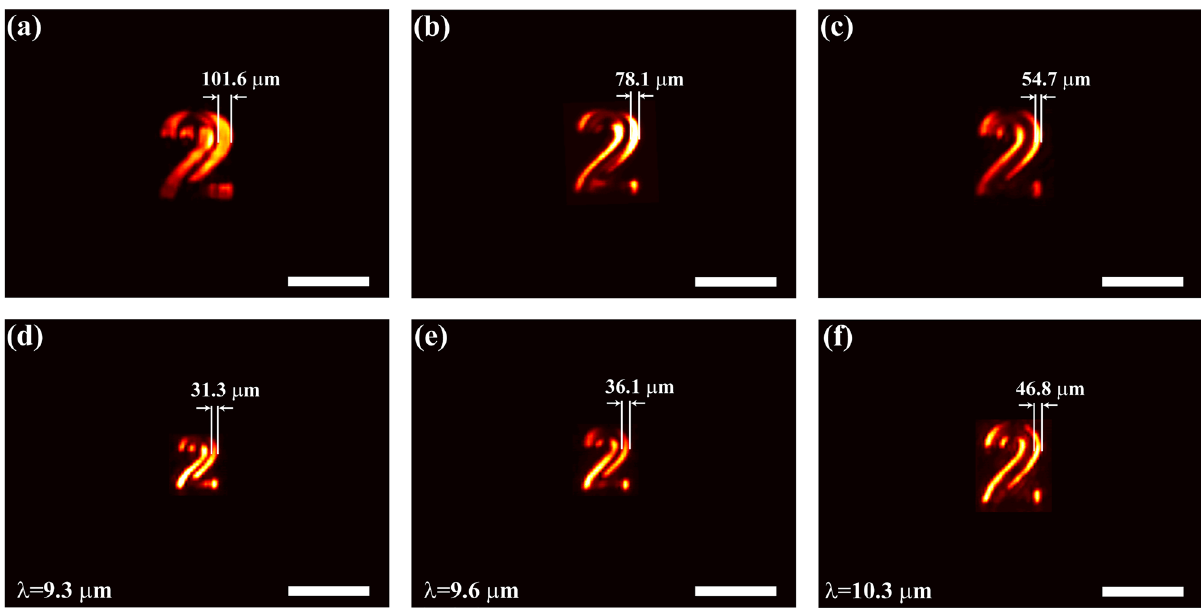
Figure 4: Demonstration of tunable edge resolution 1D edge detection and broadband 1D edge detection. (a), (b), and (c) 1D edge images of the number “ 2 ” by using S1, S2, and S3 at 10.6 μ m. (d), (e), and (f) Broadband 1D edge detection demonstrated by S3 at the wavelengths of 9.3, 9.6, and 10.3 μ m, respectively. The edge detection can work at broadband from 9.3 to 10.6 μ m (scale bar is 500 μ